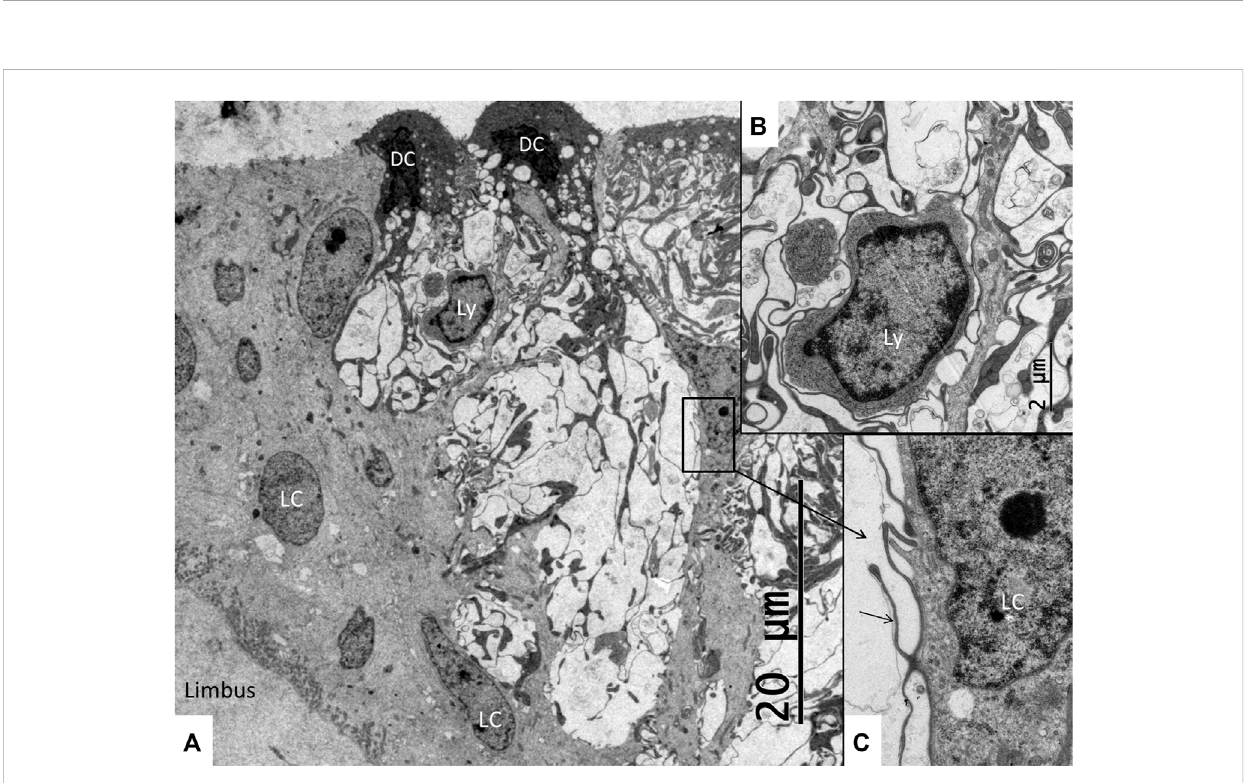
FIGURE 8 Electron microscopy of the SV near the hyaline cells. Both dark cells (DC) and light cells (LC) are seen forming large intercellular spaces containing dark cell enfoldings. The spaces contain lymphocyte-like cell (Ly) magni fi ed in B and (C) . (B) Higher magni fi cation of the free cell shown in (A) . It is surrounded by dark cell lamellae (arrow) further magni fi ed in (C) . (C) Higher magni fi cation shows cell lamellae adhering to the cell coat of the lymphocyte-like cell. The light cell nucleus contains a prominent